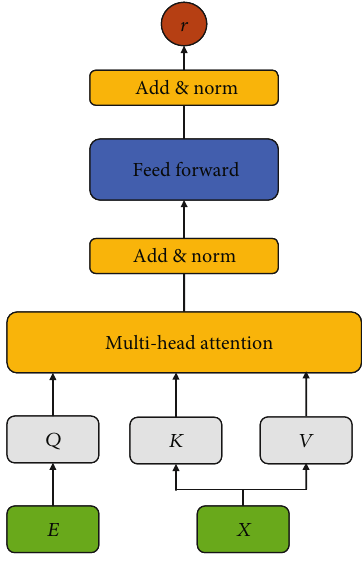
Figure 1: SAKT structure